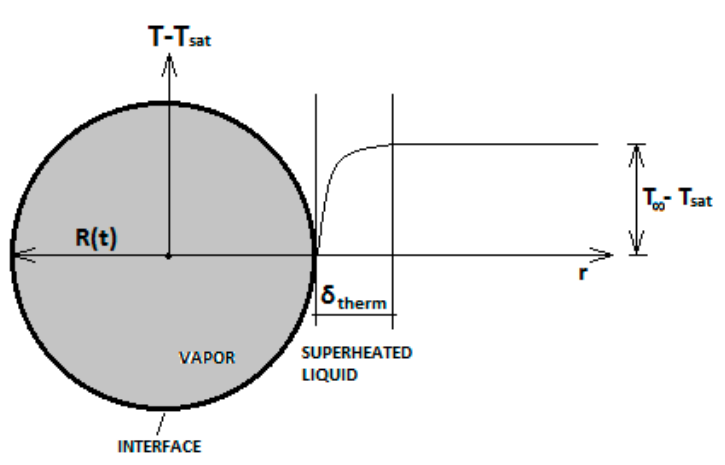
Figure 2. Schematic illustration of the geometrical characteristics and the initial conditions of the simulated validation cases.